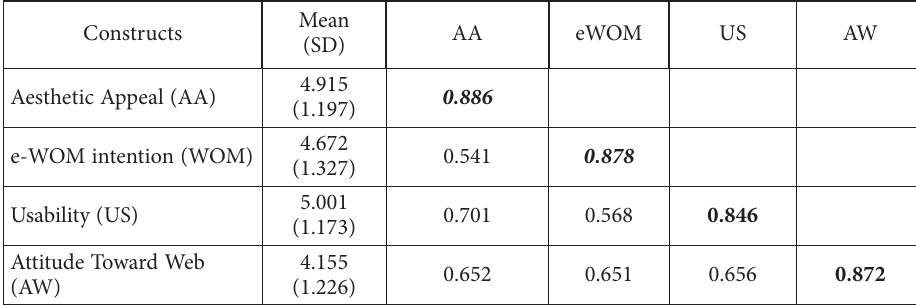
Table 4. Assessment of discriminant validity